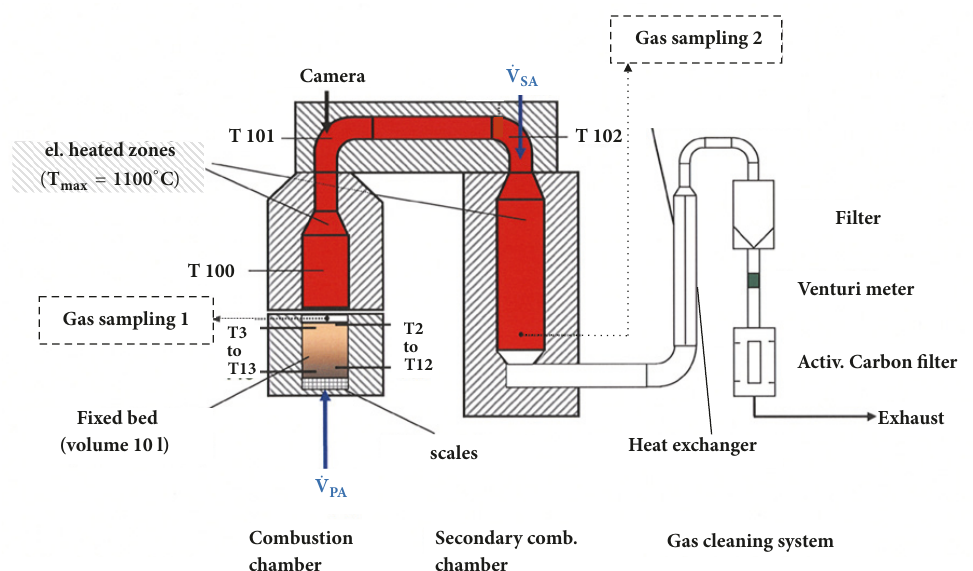
Figure 1: Schematic view of the fixed bed reactor KLEAA [9, 11].